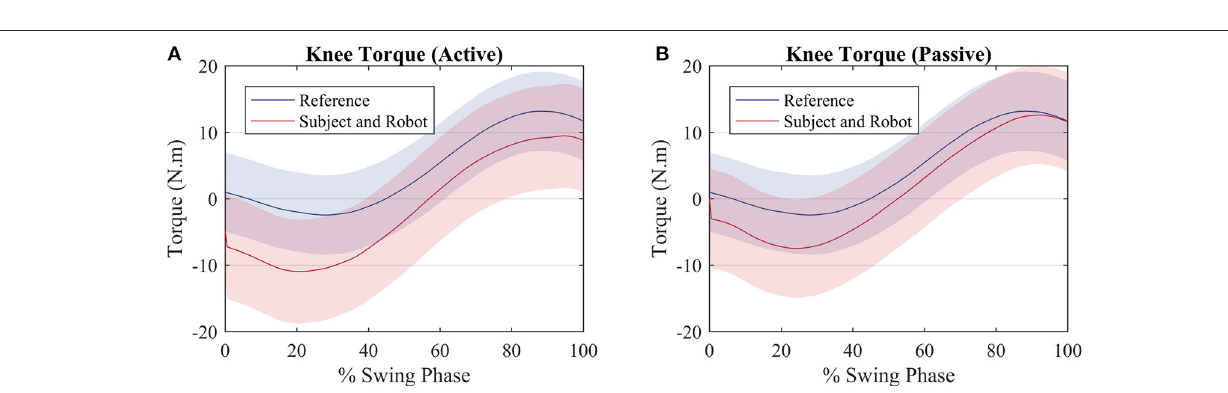
smoother robot assistance and steadier gait. To extract the patient weights, w pat , and compare with the reference ones, the algorithm must receive the pseudo-inverse of the primitive torques, p †